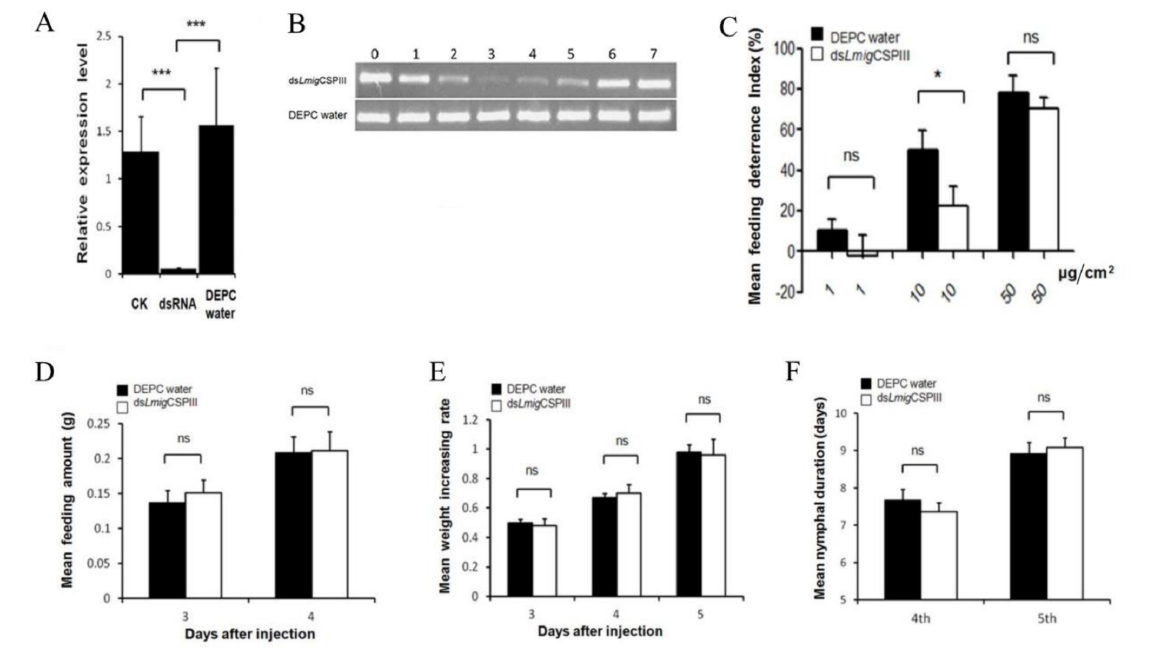
Figure 6. Suppression of Lmig CSPIII expression decreased the locust’s perception of AMCAL. ( A ) Silencing efficiency was determined by qRT-PCR of mouthparts tissues on day 3 of the fourth instar nymphs (***, p < 0.001, AVONA, Dunnett test; n = 5–10). ( B ) Efficiency of RNA interference, as assessed by RT-PCR after injection with ds Lmig CSPIII. 0, represents non-injection; 1, 2, 3, 4, 5, 6 and 7 represent day(s) after injection with dsLmigCSPIII or DEPC water. (C) Locusts with Lmig CSPIII-knockdown were less sensitive to the antifeedant than the H 2 O-injected controls (*, p < 0.05, t -test; n ≥ 20; dual-choice test). ( D – F ) Feeding amount, weight increase and nymphal duration were not influenced by Lmig CSPIII suppression ( t -test; n = 15–20; non-choice test). Each point represents the mean value ± S.E.M (standard error of mean) of three independent replications. ns; no significant